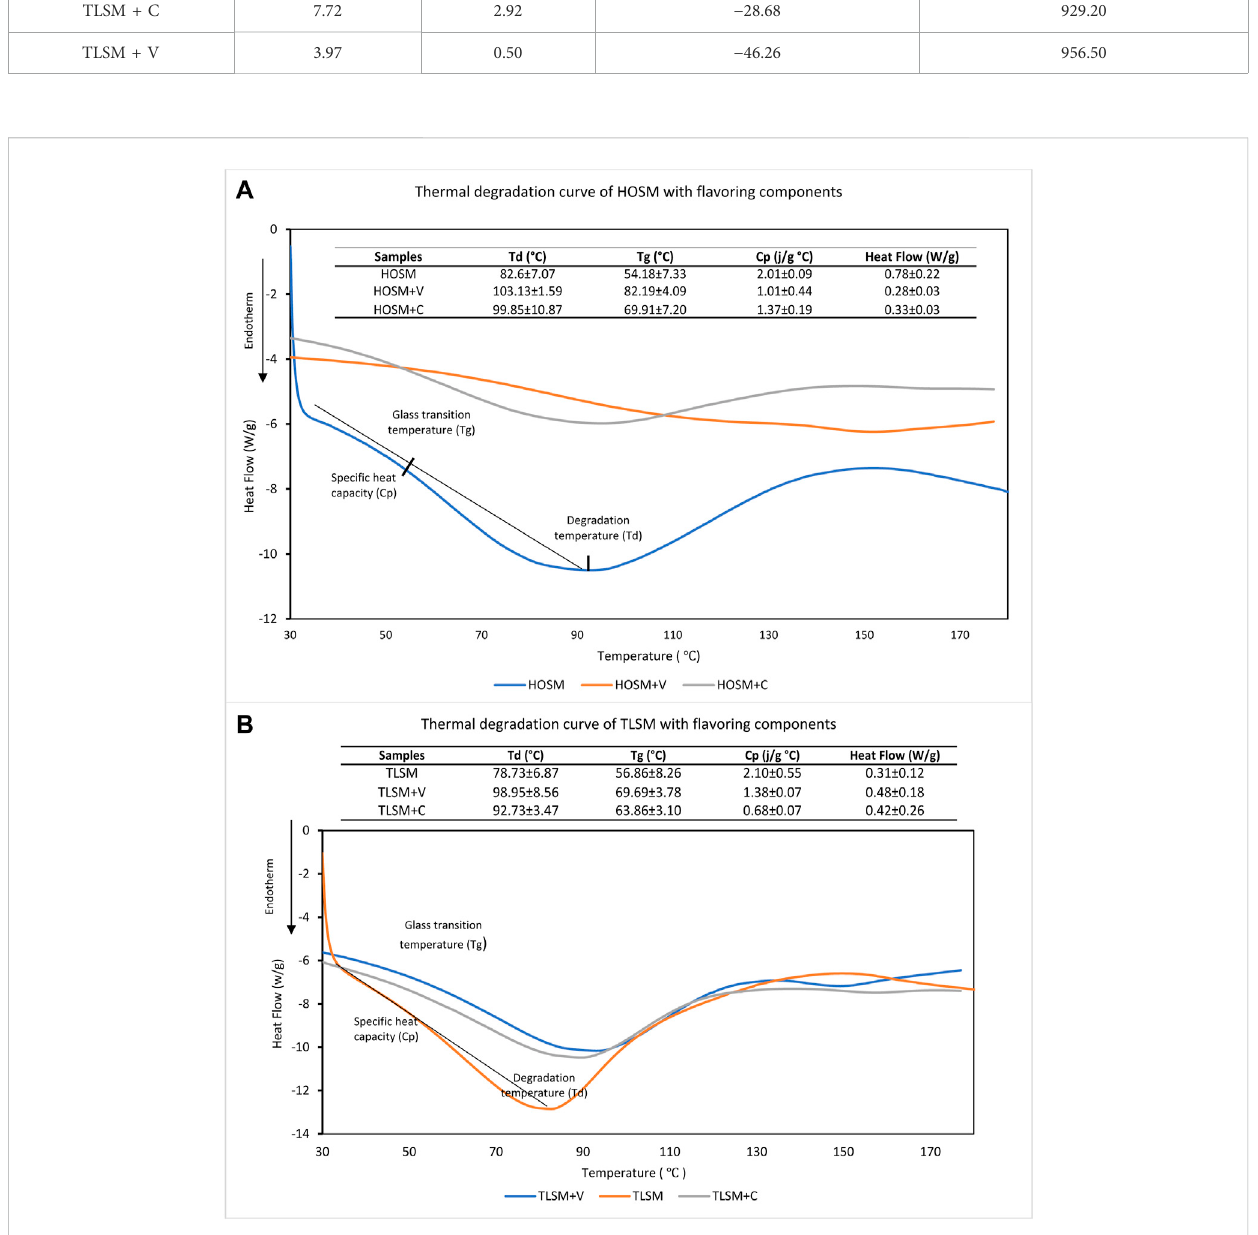
FIGURE 2 Thermal degradation curve for soymilk (A) HOSM (B) TLSM powder with the fl avoring